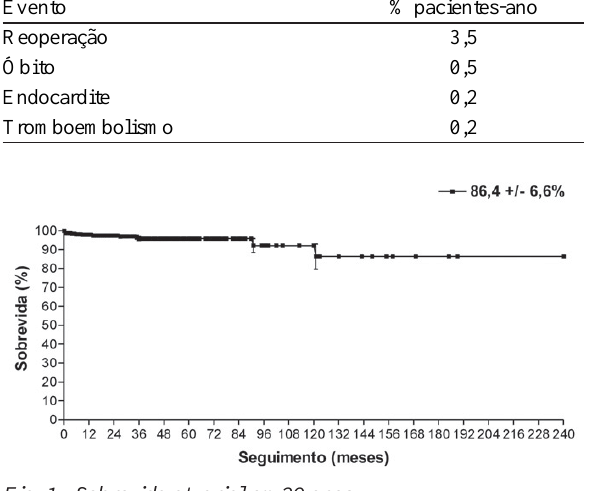
Fig. 1 - Sobrevida atuarial em 20 anos